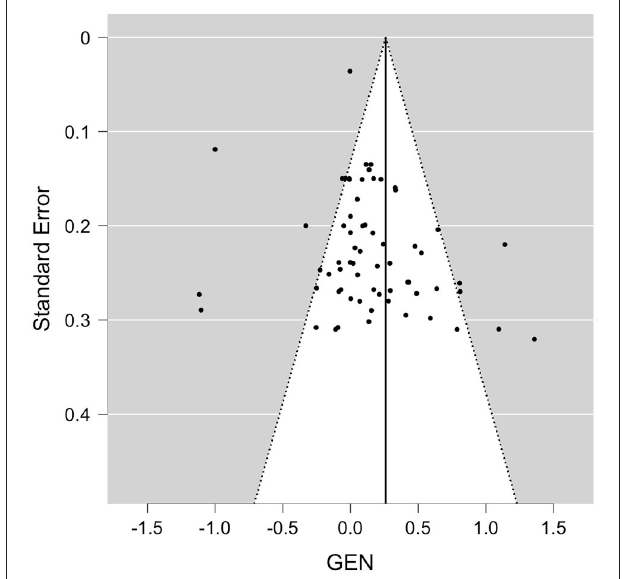
FIGURE 3 | Funnel plot for available study results for WM. GEN, general effect result per